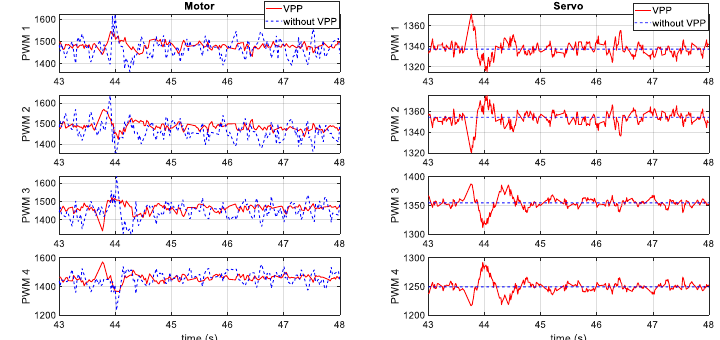
Figure 15. Pulse-width modulation (PWM) signals from the controller to the four motors and four servos.